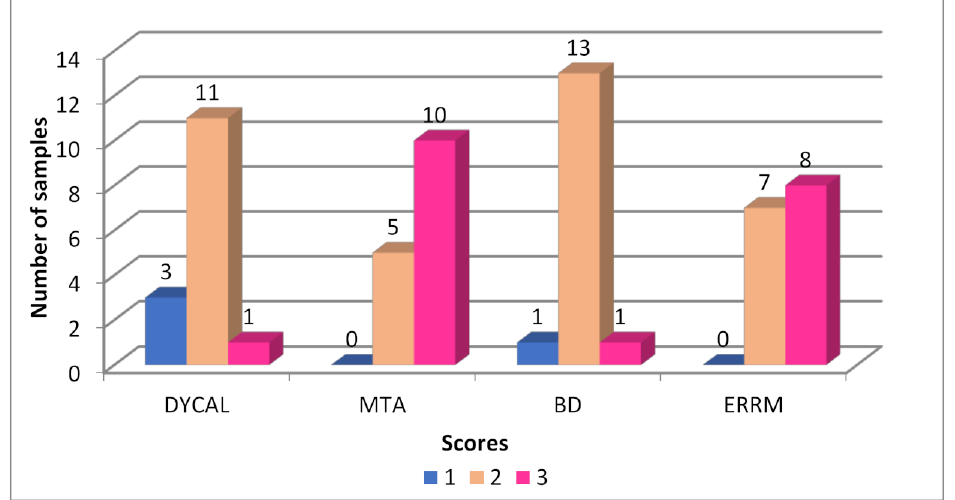
Figure 5. A histologic dentinal bridge comparison among the pulp-capping agents (1—calcified areas not confirmative of dentin; 2—amorphous dentin; 3—tubular